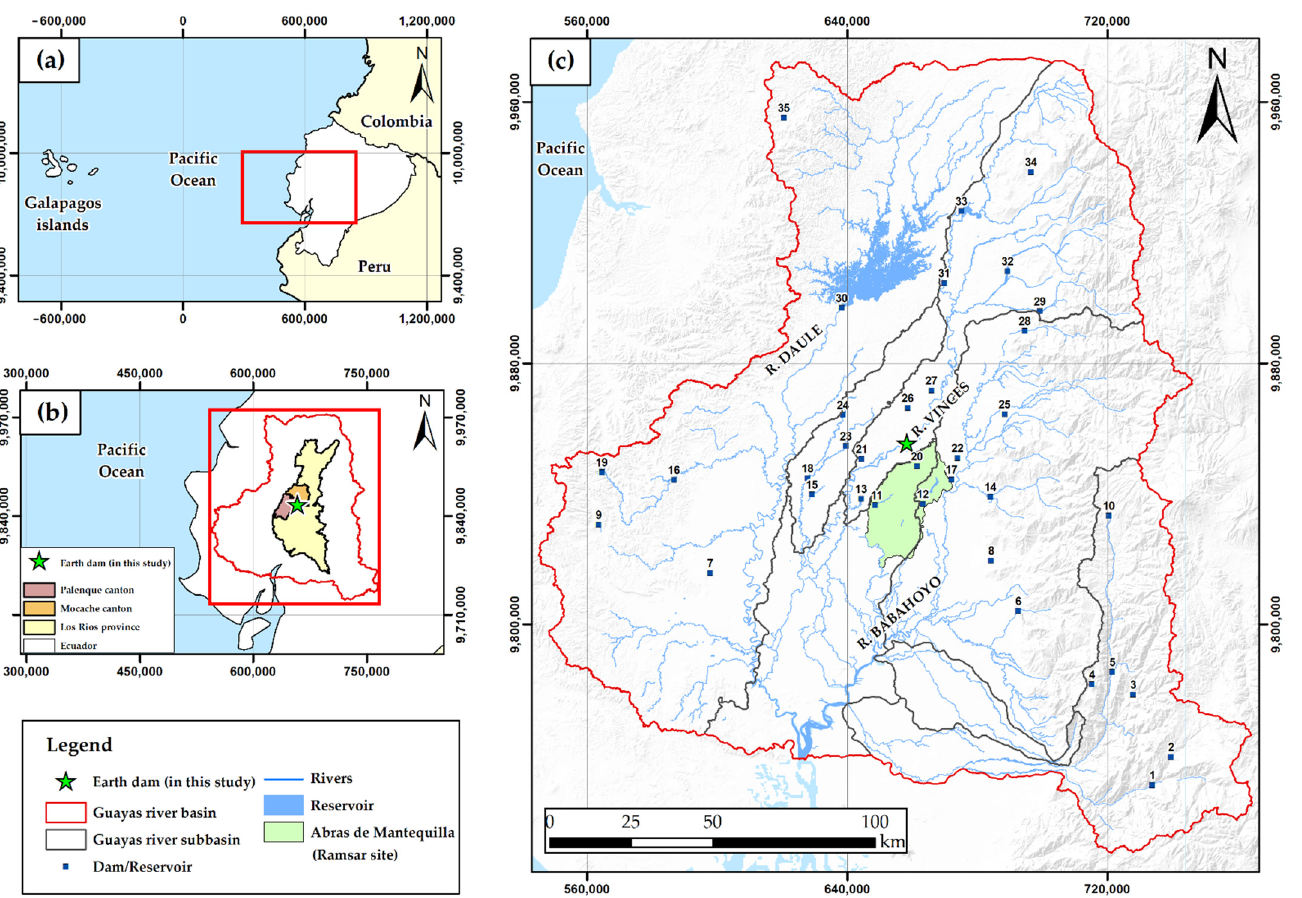
Figure 1. Study area location: ( a , b ) Los Ríos province and main cantons within the earth dam zone proposed in the present study; ( c ) Guayas river basin, Guayas river subbasin and Hydraulic works or infrastructure (reservoirs and dams) location in the area by [32], 1: Guashán, 2: Chanconvento, 3: Coco, 4: Chillanes, 5: Pangor Bucay, 6: Cristal, 7: Bufay, 8: Pita, 9: Paján, 10: Salimoya, 11: Chojampe,